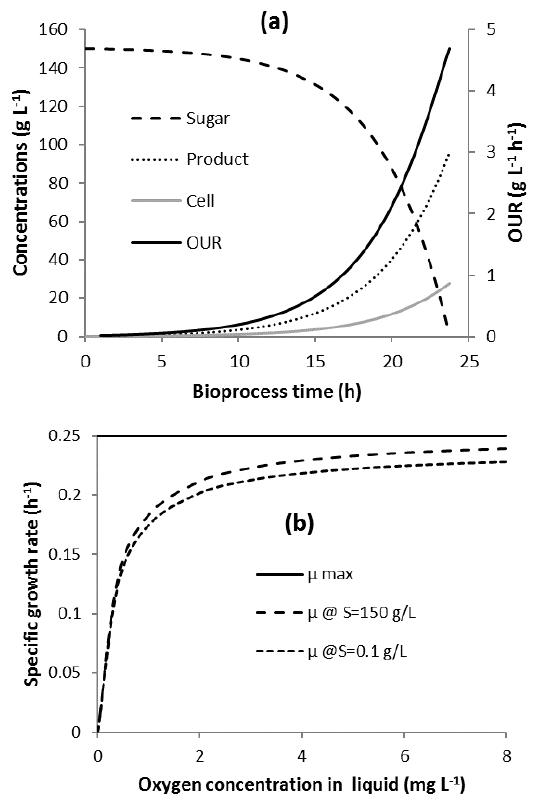
Figure 1. Microbial kinetics: ( a ) cell, sugar and product concentrations and oxygen uptake rate (OUR) (Scenario K: Pag = 45 kW; vvm = 1); ( b ) effect of oxygen and sugar concentrations on specific growth rate.